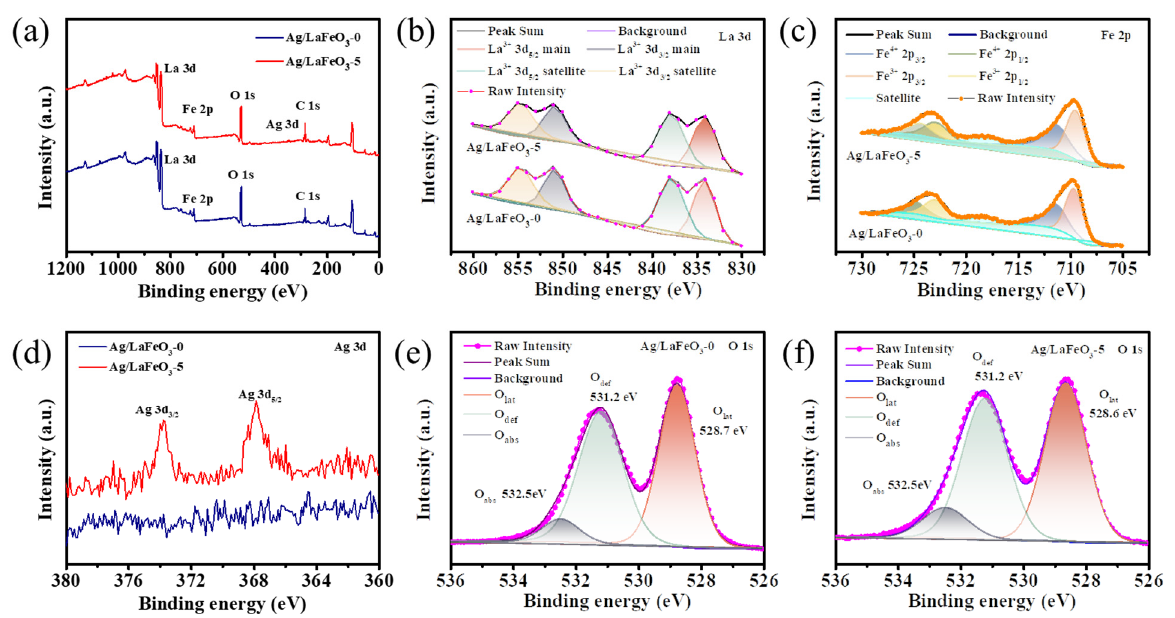
Figure 4. ( a ) XPS survey spectra of Ag/LaFeO 3 − 0 and Ag/LaFeO 3 − 5, high-resolution core-level XPS spectra of; ( b ) La 3d; ( c ) Fe 2p; ( d ) Ag 3d; ( e ) O 1s of Ag/LaFeO 3 − 0; and ( f ) O 1s of Ag/LaFeO 3 −